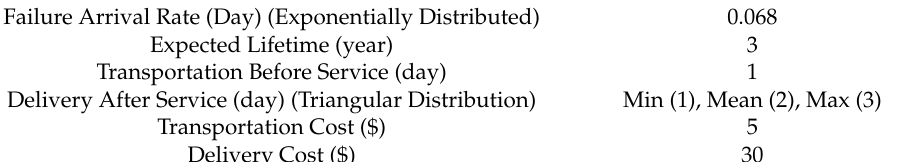
Table A3. Maintenance data.